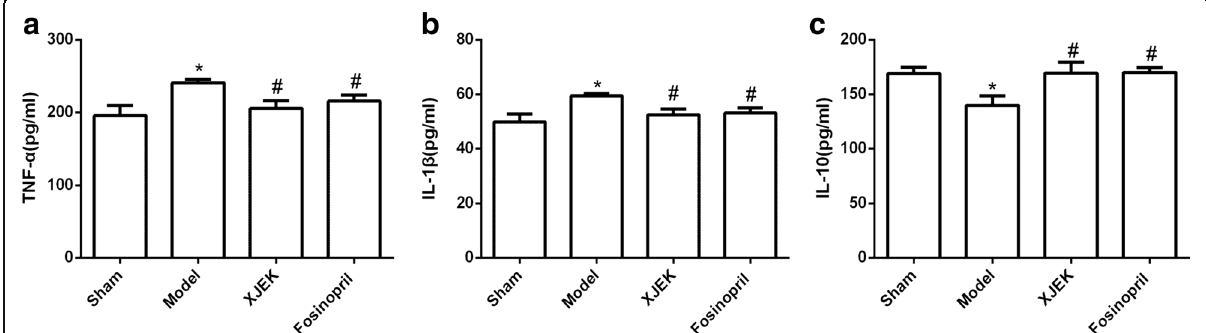
Fig. 9 Effect of XJEK on TNF-1 α ( a ), IL-1 β ( b ) and IL-10 ( c ) content in cardiac tissues of MI mice (mean ± SEM, n = 6 – 9). * P < 0.05, ** P < 0.01 vs. Sham group; # P < 0.05, ## P < 0.01vs.Model